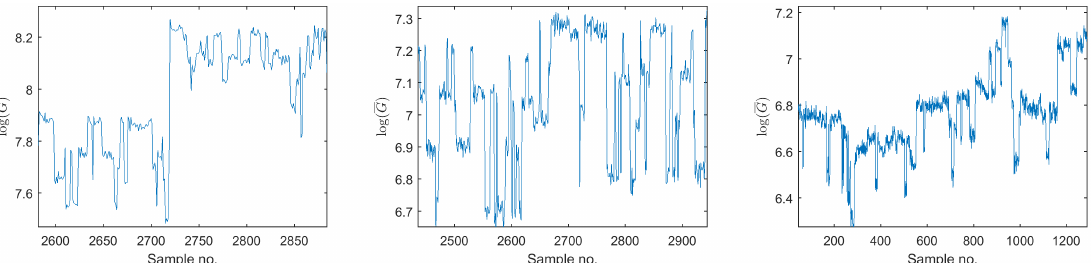
Figure 6. Examples of multilevel metastability of log G in three random pixels of the BAb satellite (obtained in